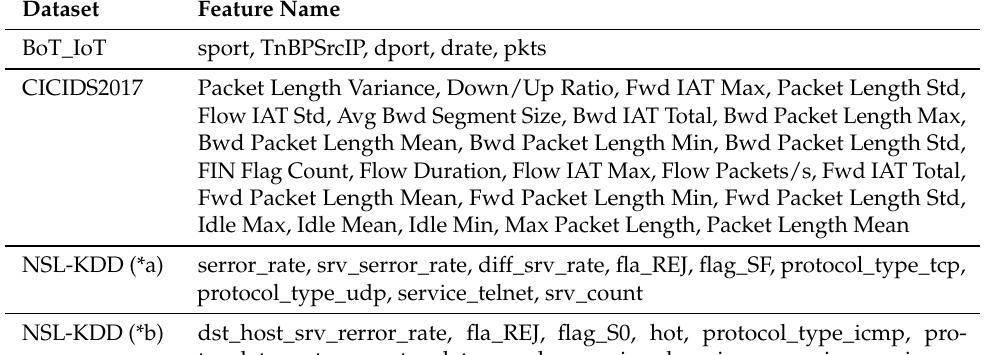
Table 6. Top features identified by five or fewer